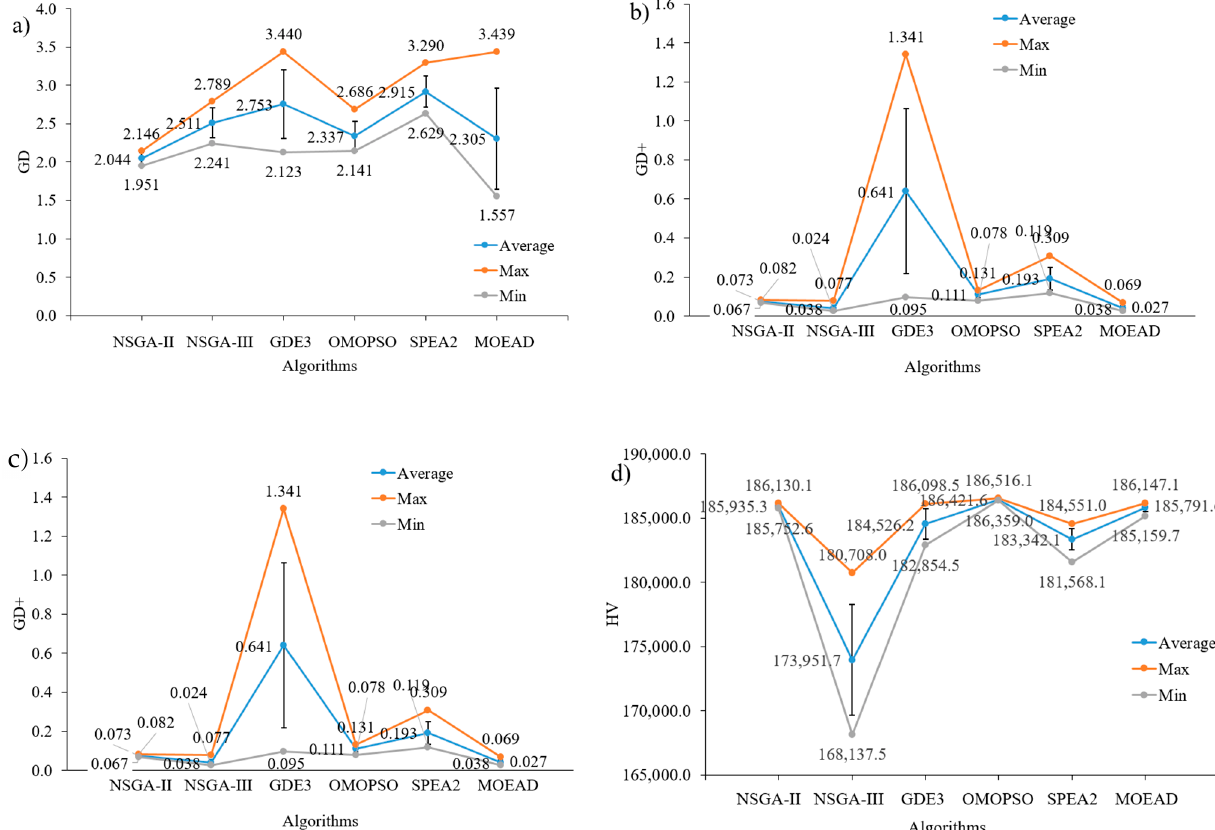
Figure 10. GD, GD+, IGD+, and HV of the MOO algorithms of the 72-bar truss: ( a ) GD; ( b ) GD+; ( c ) IGD+; ( d ) HV.